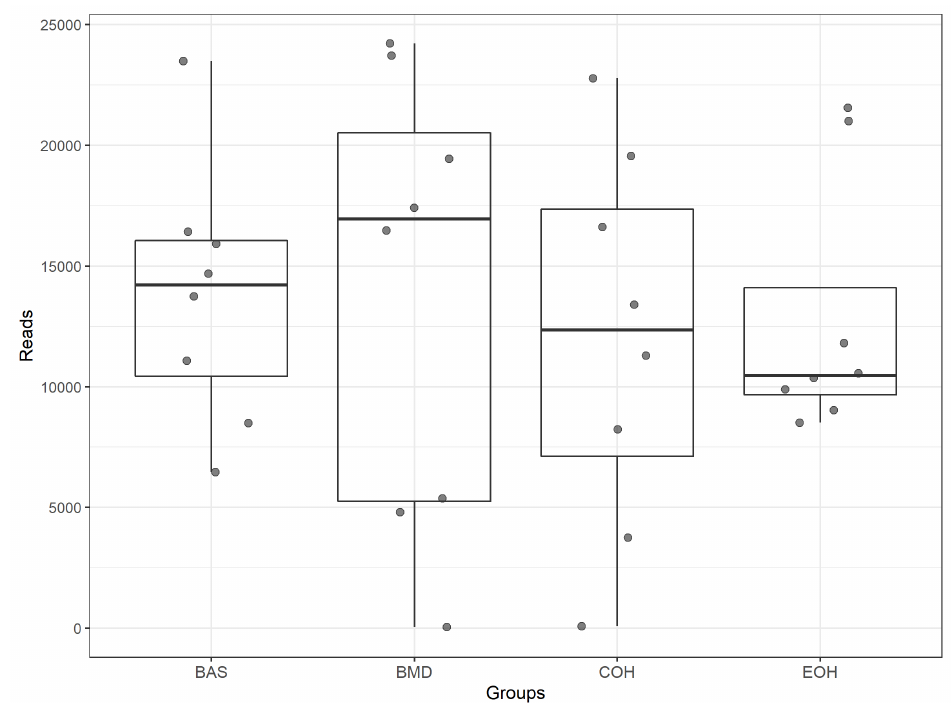
Figure 1. Box-and-whisker plot illustrating the total number of quality filtered per sample. These reads reflect the total number of high-quality sequences that align with 16Sv4, clustered into OTUs, and were assigned a taxonomic classification. BAS = basal diet; BMD = antibiotic diet; COH = diet supplemented with 3% coarse oat hulls; and EOH = diet supplemented with 3% extruded oat hulls. Animals 2020 , 10 , x